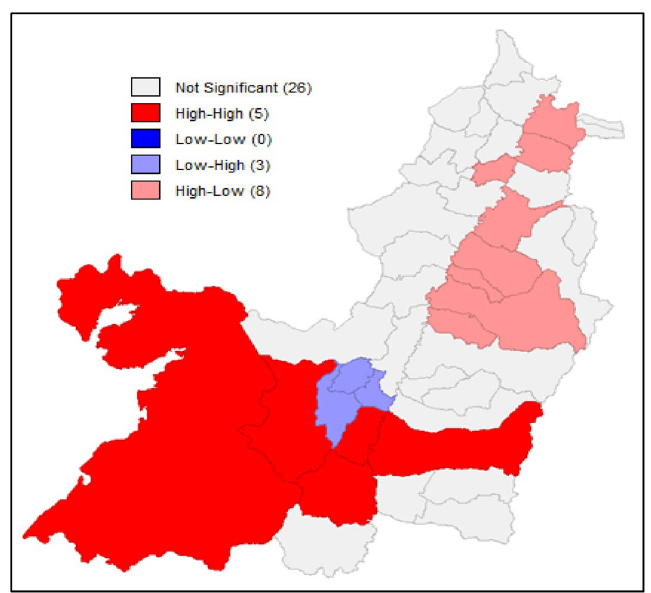
Fig. 1 Bivariate Moran Index between the 2010 fiscal efficiency and the categorization of the area (by metropolitan area). Source: own computation based upon GeoDa (2020)